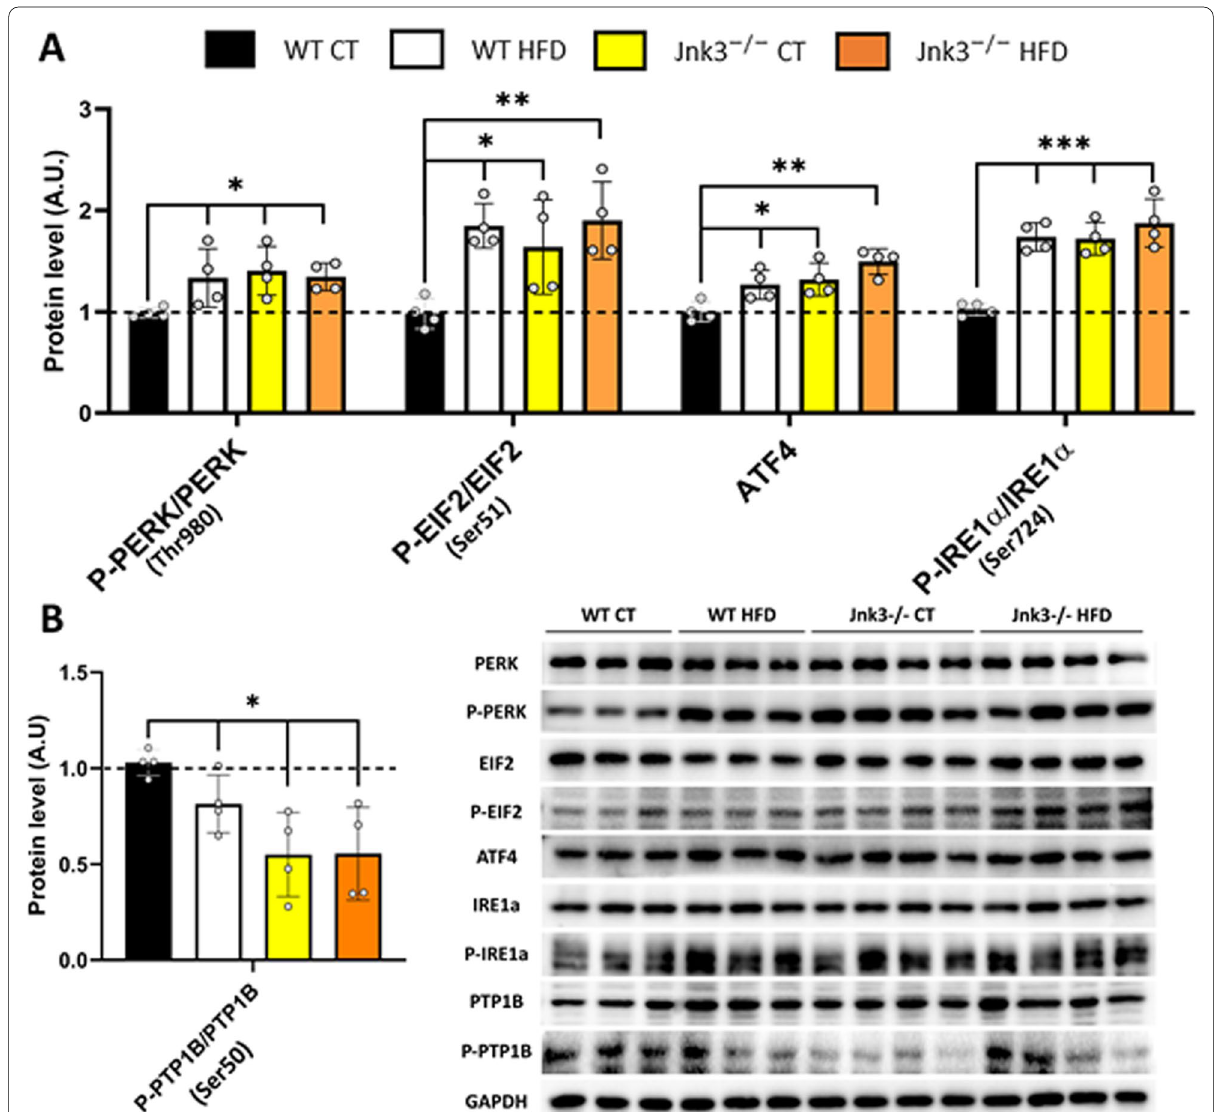
Fig. 6 Loss of function of JNK3 promotes dysregulation of normal metabolic function. Protein levels were detected. A Endoplasmic reticulum‑related [PERK, P‑PERK (Thr980), EIF2, P‑EIF2 (Ser51), ATF4, IRE1α and P‑IRE1α (Ser724)] and B PTP1B and P‑PTP1B (Ser50). Results were represented as bar graphs and differences between groups was analyzed using ANOVA and Tukey’s (n was represented as follows: *p < 0.05, **p < 0.01 and ***p <